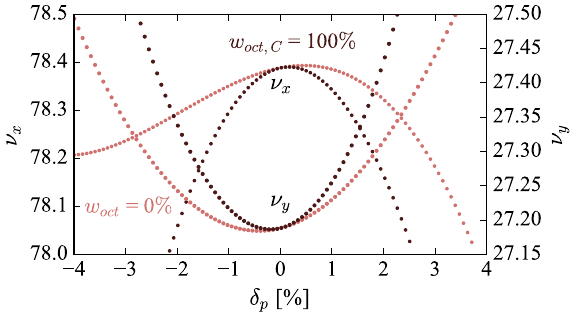
and oct C H ; w oct ; C oct ; H Þ ¼